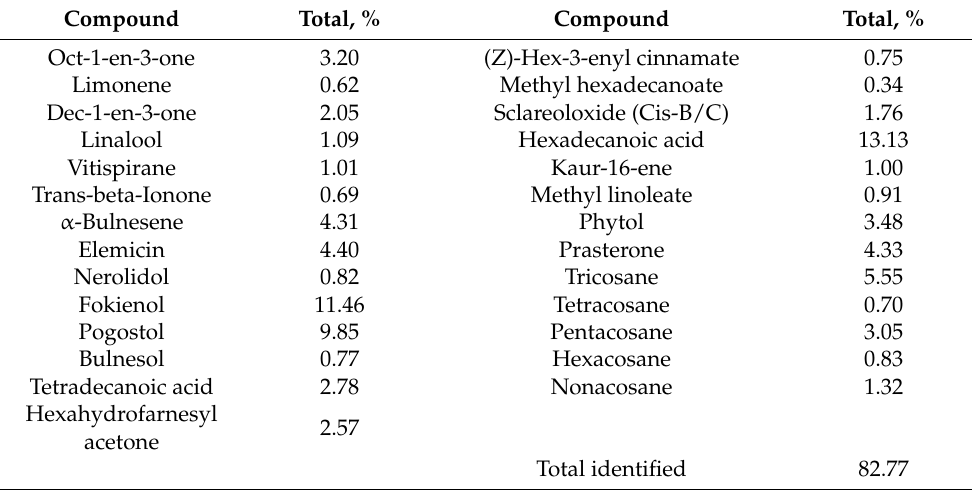
Table 1. Chemical components of volatile oil in O. pseudoglandulosa